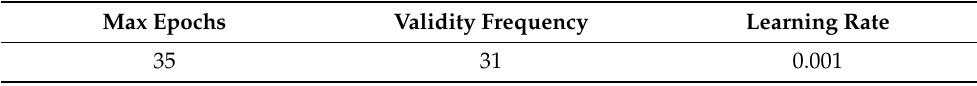
Table 4. Hyperparameters of the proposed CNN model.